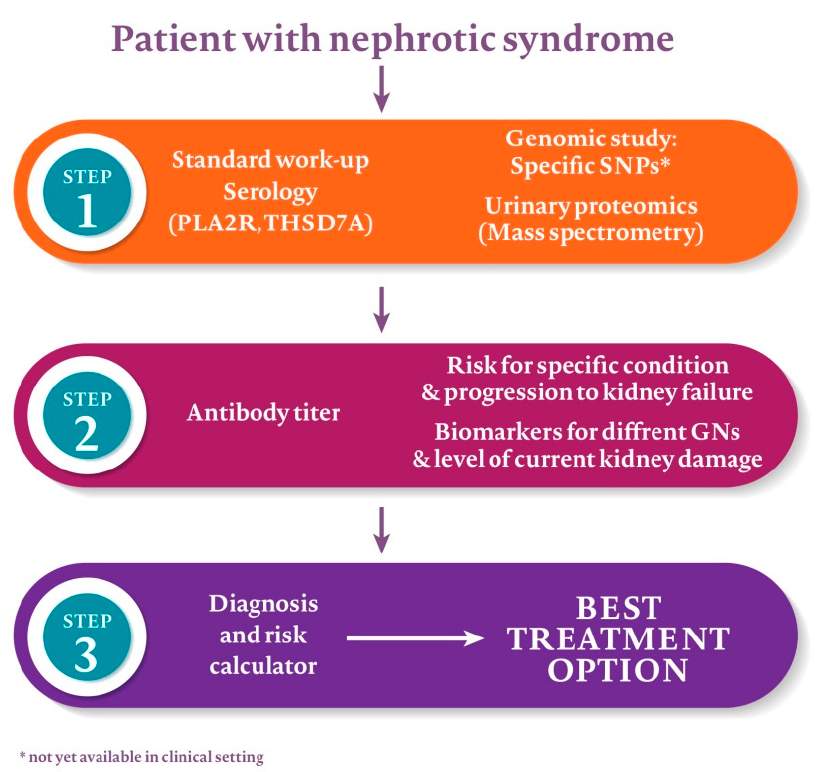
Figure 4. Possible future approach to a patient with nephrotic syndrome .